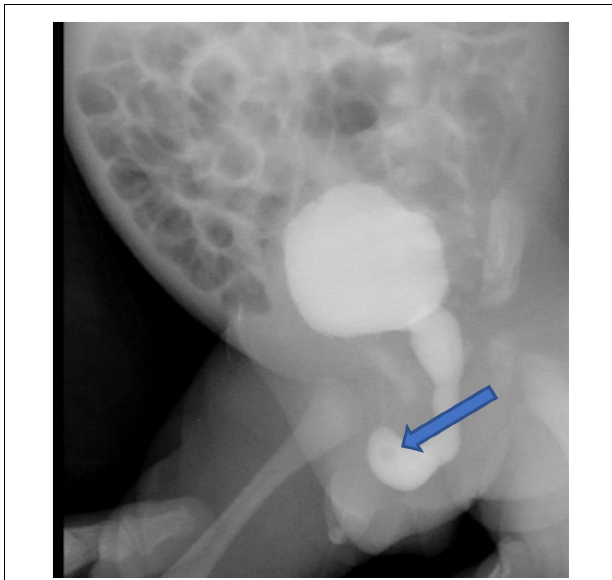
Some have been proposed as possible mechanisms that are related by excessive urethral tissue during embryonic development (11).